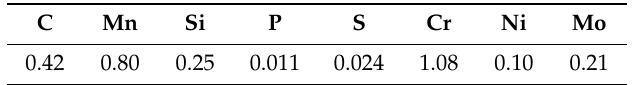
Table 4. Chemical composition in wt % of the 42CrMo4E steel grade.